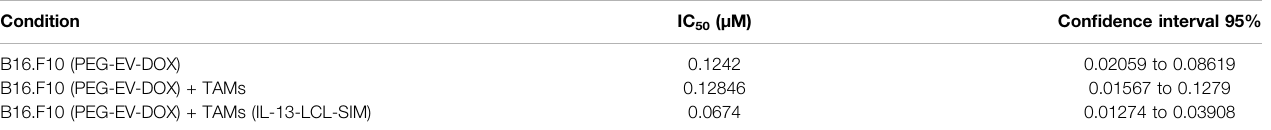
TABLE 3 | IC 50 of the treatments on B16.F10 proliferation in co-culture with TAMs.